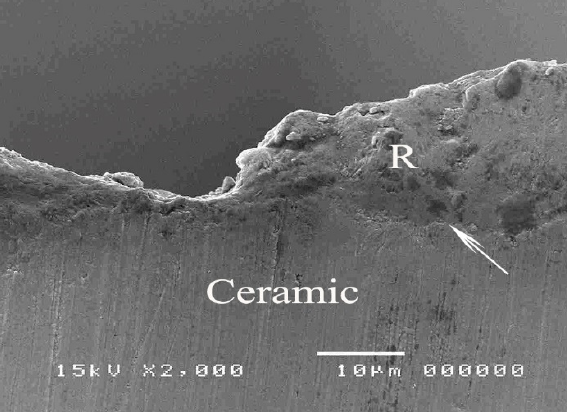
Figure 9. SEM micrographs demonstrating well-impregnated Super-Bond resin into the irregular pits and fissures (arrowed) of the fractured specimens in ( a ) metal alloy and ( b ) resin composite specimens (original 2000 × , R = luting resin).